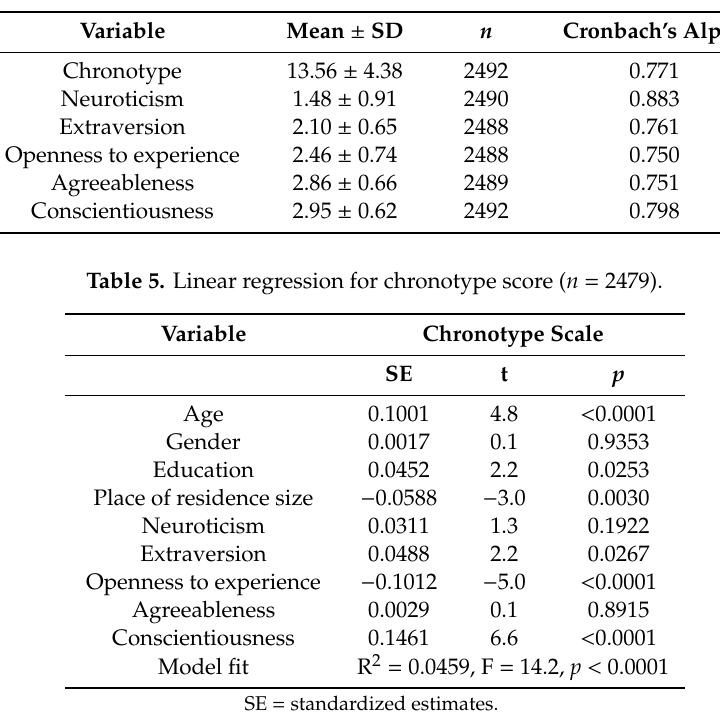
Table 4. Mean and standard deviations of chronotype and personality variables.